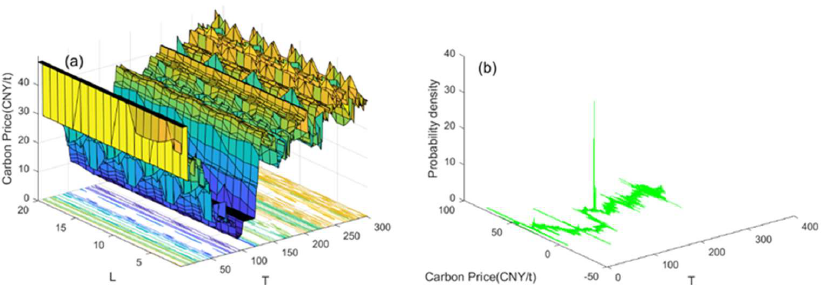
Figure A4. Price data and probability density distribution of carbon market in Hubei, ( a ) evolution of daily closing price data; ( b ) distribution of probability density.